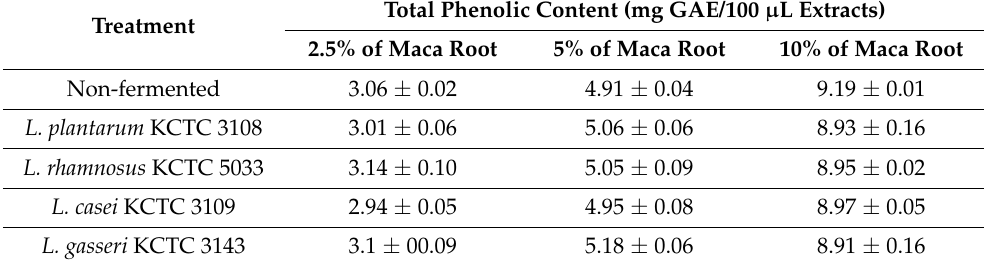
Table 2. Total phenolic contents of the non-fermented and fermented maca root extracts.